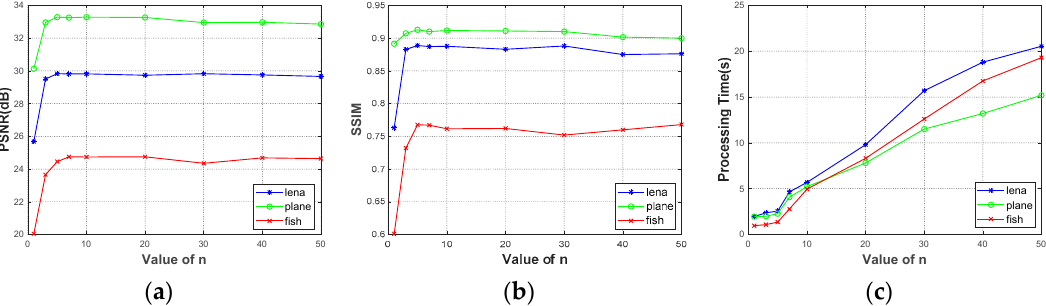
Figure 4. Effects of iteration steps number on the results: ( a ) PSNR, ( b ) SSIM, and ( c ) processing time.